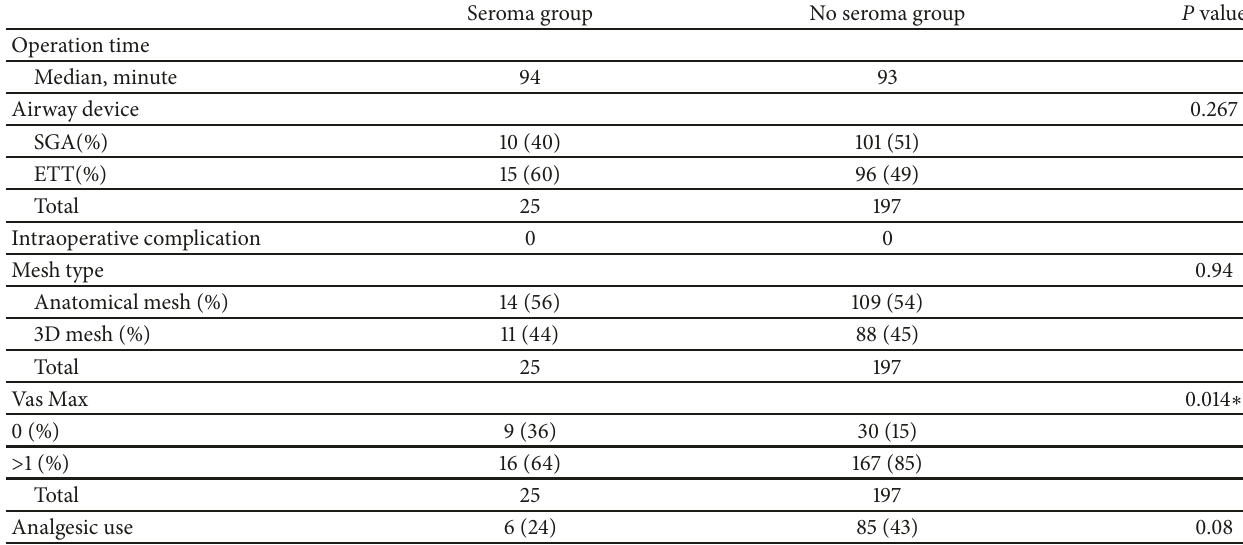
Table 4: Intraoperative and postoperative data.